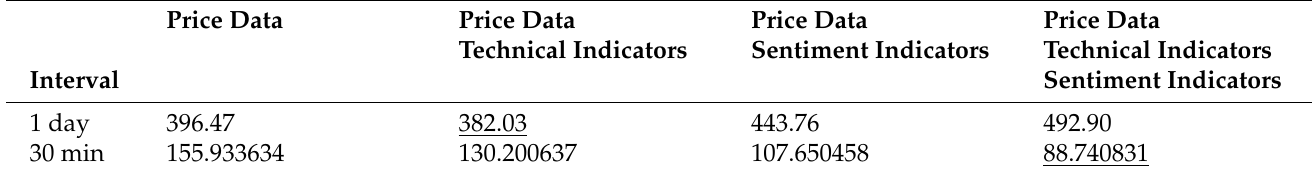
Table 7. Comparison of the MAE obtained by the stacking ensemble with different intervals.